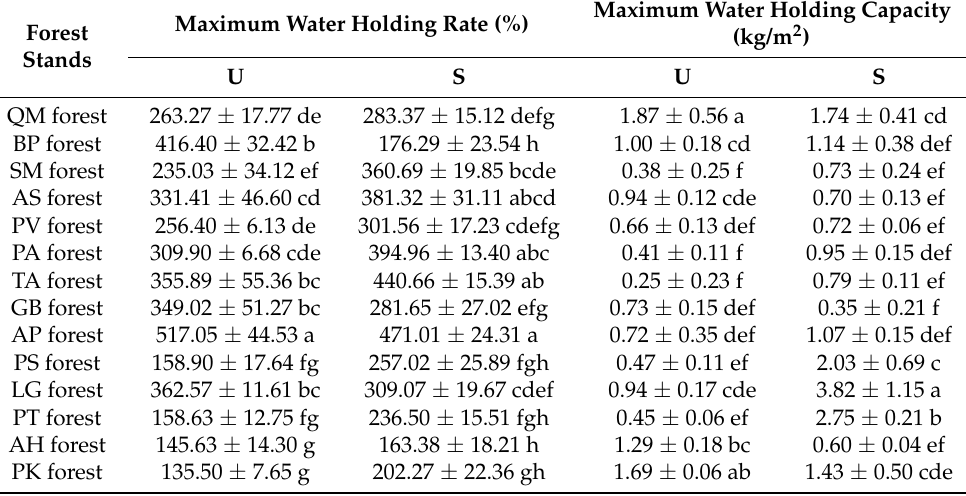
Table 4. Litter maximum water holding rate and capacity (mean ± SD) in different decomposition degrees. Note: Different lowercase letters indicate significant differences among tree species at the 0.05 level. U indicates un-decomposed layer and S indicates semi-decomposed layer. The abbreviation of tree species is the same as Table 1. Maximum Water Holding Capacity Maximum Water Holding Rate (%) Forest (kg/m 2 Stands